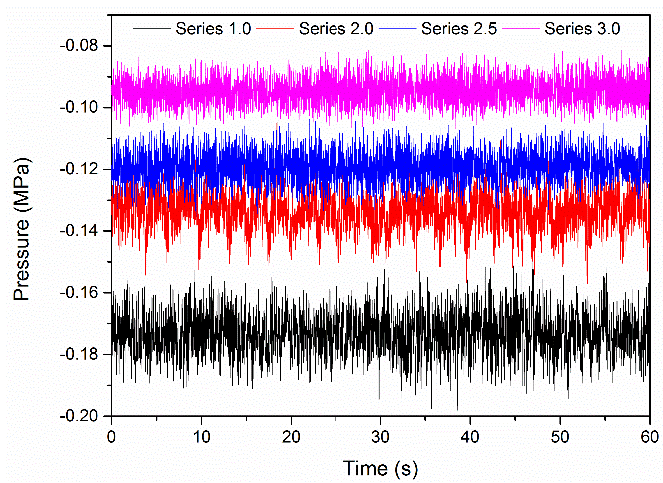
Figure 15. Chamber pressure signal under various suction series.